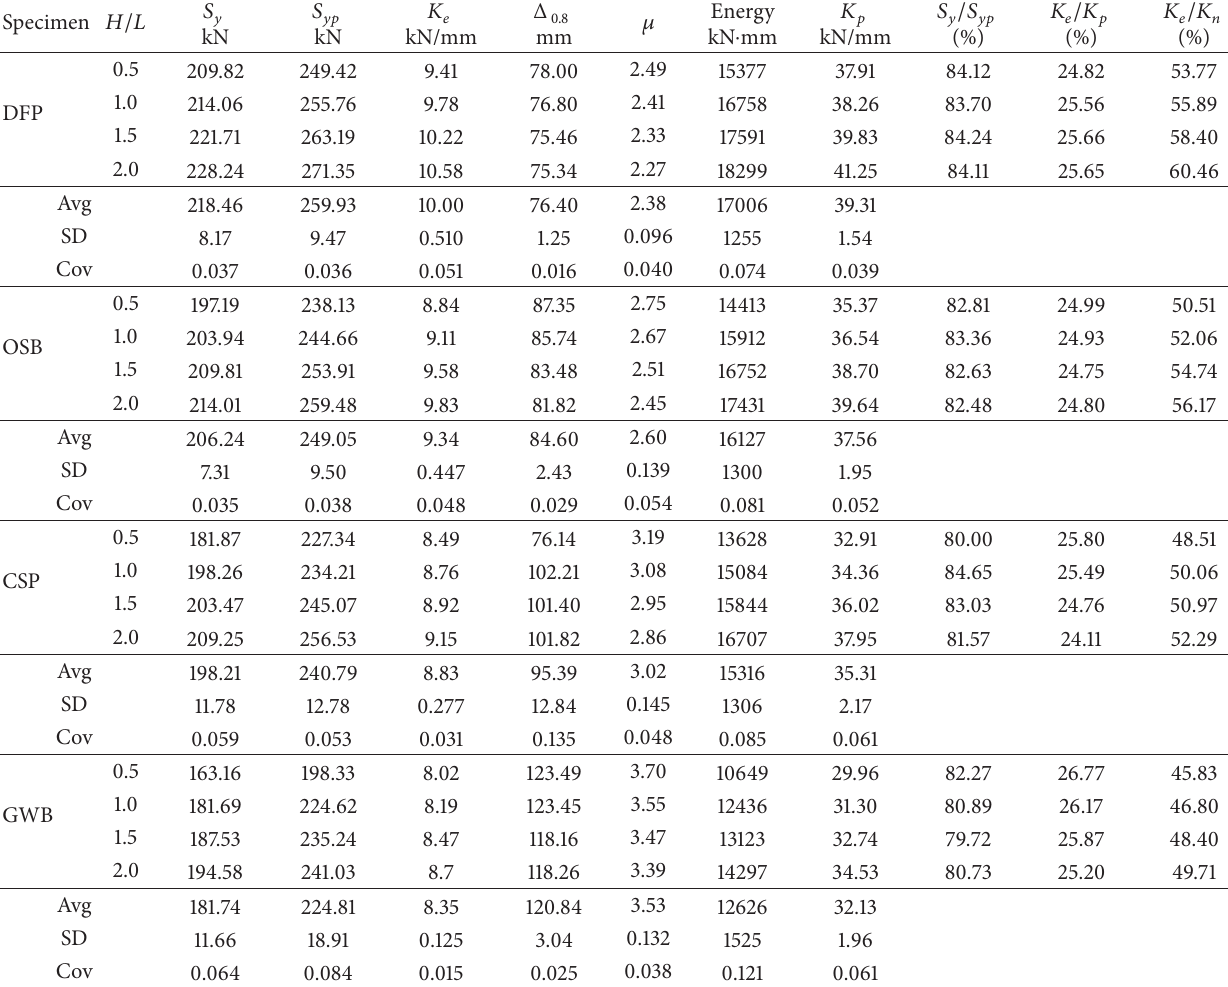
Table 6: Monotonic loading specimens of 1-side sheathed CFS results with thickness of 12.5 mm. Specimen